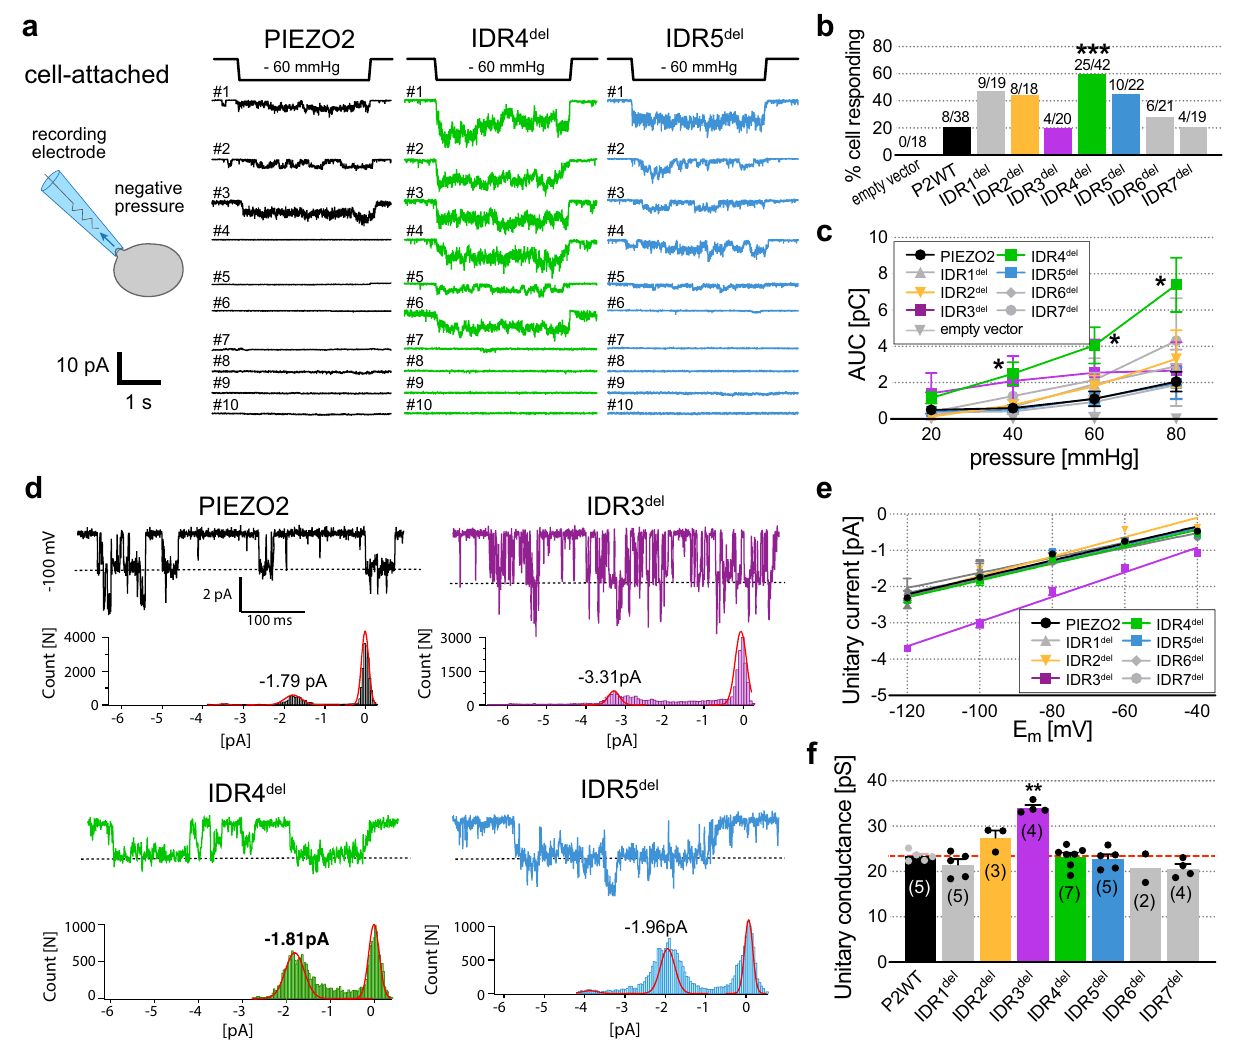
Fig. 2 Deletion of IDR3 and IDR4 impairs stretch- and single channel-responses of PIEZO2. a Cartoon illustrating the pressure-clamp technique (left) and example traces (right) of stretch-activated PIEZO2, IDR4 del and IDR5 del -currents recorded from 10 different cells in cell-attached mode (holding potential = − 100 mV, pressure stimulus = − 60 mmHg). b Comparison of the proportion of cells responding to pressure-induced membrane stretch amongst cells expressing GFP (empty vector), PIEZO2 and the individual IDR del mutants. Labels above bars (X/Y) indicate how many (X) from Y tested cells responded. Fisher ’ s exact test, PIEZO2 vs IDR1 del ns p = 0.0646, PIEZO2 vs IDR4 del *** p = 0.0006, PIEZO2 vs IDR5 del ns p = 0.07801. c Stimulus (pressure) – response (area under the curve, AUC) curves of PIEZO2 and IDR del mutants (for example traces see Supplementary Fig. 4). Symbols represent means ± s.e.m. Comparison with Kruskal – Wallis test ( p = 0.0569 − 20 mmHg, p = 0.0222 − 40 mmHg, p = 0.0041 − 60 mmHg, p = 0.0043 − 80 mmHg) and Dunn ’ s post-test, PIEZO2 vs IDR4 (* p = 0.0427 − 40 mmHg, * p = 0.0427 − 60 mmHg, * p = 0.0483 − 80 mmHg). N-numbers of cells per group are the same as in b . d Example traces (top) of stretch-activated PIEZO2 (black), IDR3 del (purple), IDR4 del (green) and IDR5 del -currents (blue) are shown together with corresponding current amplitude distribution histograms (bottom, peak values of Gaussian fi ts – i.e., unitary currents – are indicated). e Linear regression fi ts of the I-V plots (mean ± s.e.m. unitary currents vs. holding potential) of PIEZO2 and the indicated IDR del -mutants. N-numbers are the same as in f . f Unitary conductance of PIEZO2 and IDR del mutants. Bars represent means ± s.e.m., with individual values from each cell shown as black circles and N-numbers shown in brackets. Comparison with Kruskal – Wallis ( p = 0.0069) and Dunn ’ s post-test, PIEZO2 vs IDR3 del , * p = 0.0096. Source data are provided as a Source Data fi